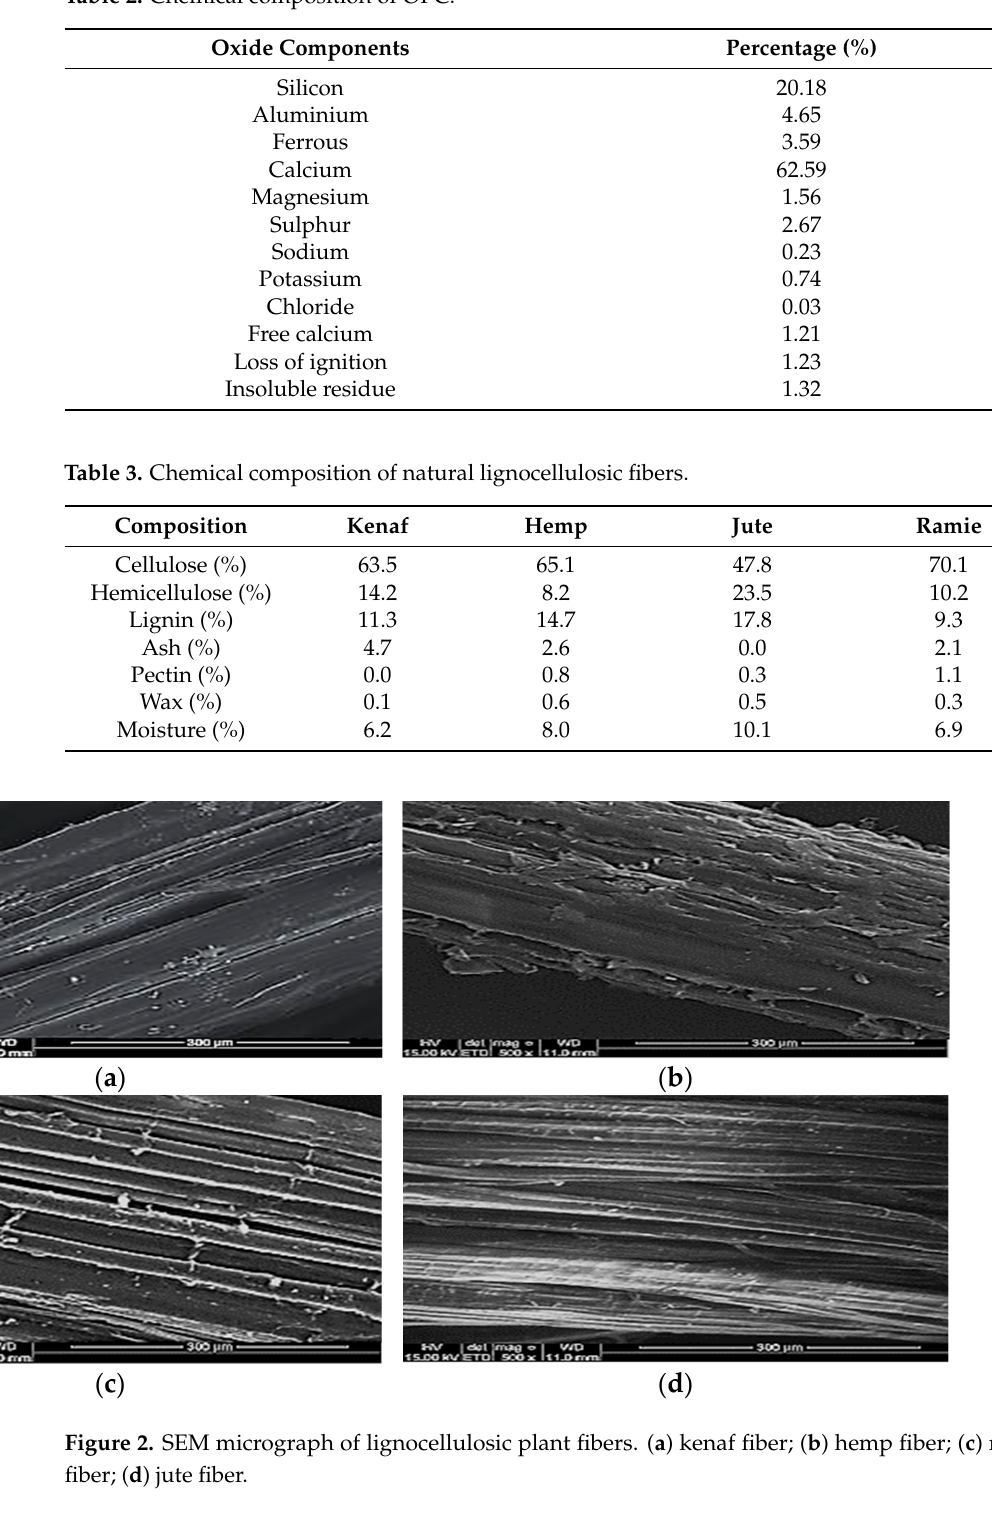
Table 2. Chemical composition of OPC.